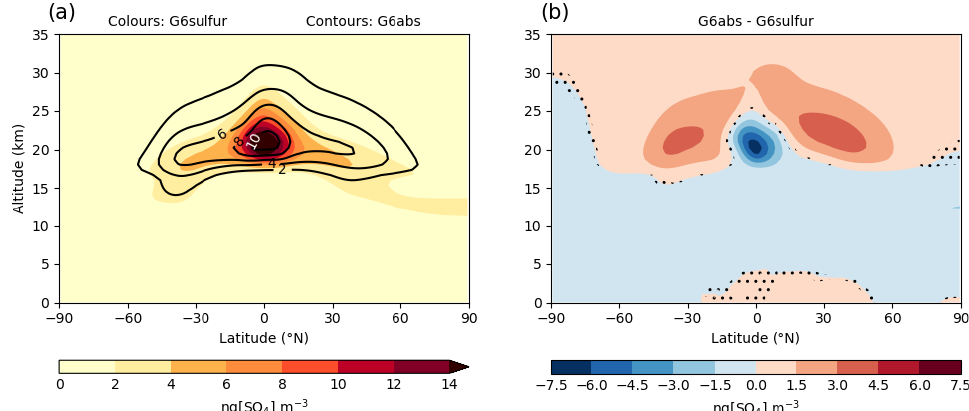
Figure 1. (a) The accumulation-mode sulfate aerosol concentrations under G6sulfur (colours) and G6abs (lines) and (b) the difference in the aerosol concentrations. Simulations are for ensemble means from 2081 to 2100. Stippling represents areas that are not significant at the 5% level using a two-tailed t -test.